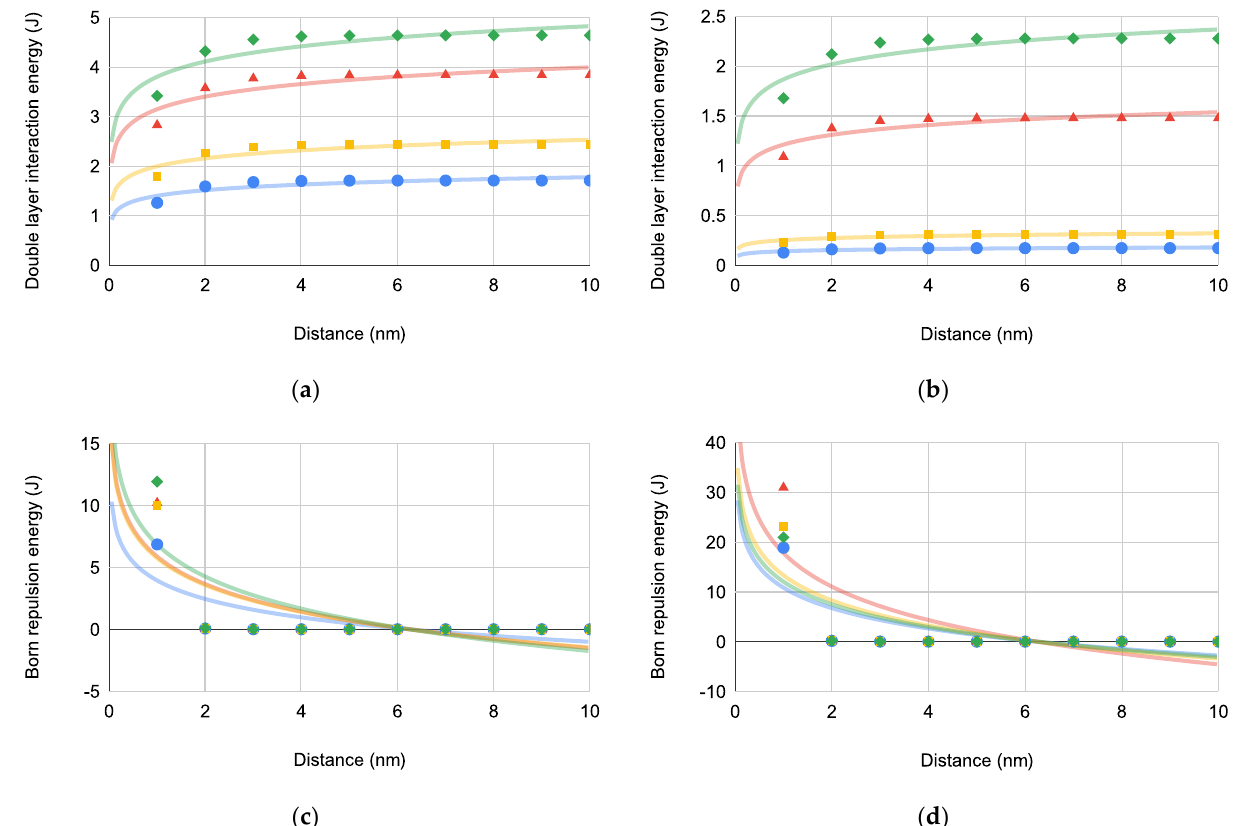
Figure 4. Bacterial Gibbs interaction energies [PA (blue circles), EC (green diamonds), SA (red triangles), and SE (orange squares)] versus distance for bacterial interactions: ( a ) 𝛥𝐺 132𝐸𝐿 (× 10 −7 ) , ( b ) 𝛥𝐺 13𝐸𝐿 (× 10 −7 ) , ( c ) 𝛥𝐺 132𝐵𝑜𝑟𝑛 (× 10 −25 ) where 𝑑 𝑒𝑞 = 6.25 ± 0.00854 𝑛𝑚 ( N = 4), and ( d ) 𝛥𝐺 13𝐵𝑜𝑟𝑛 (× 10 −25 ) where 𝑑 𝑒𝑞 = 6.24 ± 0.00957 𝑛𝑚 ( N = 4).